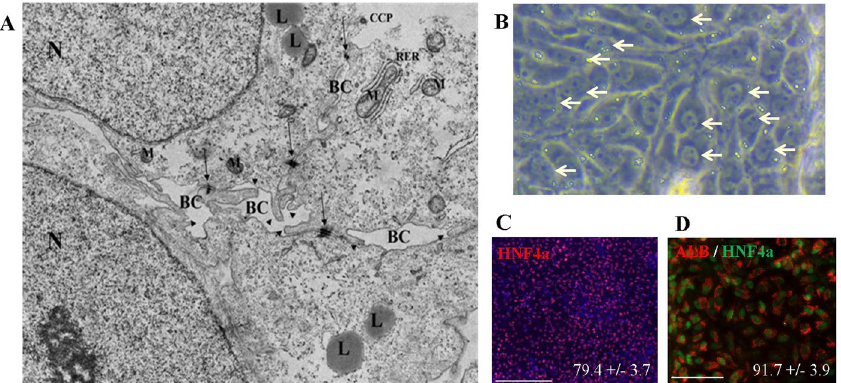
Figure 3. Ultra structure and maturation. ( A ) Electron microscopy image of E-iPSC-HLCs. BC = bile canaliculi; L = lipid; CCP = clathrin coated pits; M = mitochondrion; RER = rough endoplasmic reticulum; N = nucleus; arrow = tight junctions; arrowhead = microvilli. ( B ) Bright field microscopy of HLCs. Bi-nuleated cells are marked by arrow-heads. ( C ) Immunofluorescence-based staining of HNF4 α in end-stage HLCs. 79.4% ( + / − 3.7%) of the cells counted positive for HNF4 α . Scale bar: 200 μ m Alexa Flour 594 (red). ( D ) Immunofluorescence-based double staining of Albumin (ALB) and HNF4 α in end-stage HLCs. 91.7% ( + / − 3.9) of HNF4 α positive cells were also positive for ALB. Scale bar: 100 μ m, Alexa Flour 594 (red) and Alexa Flour 488